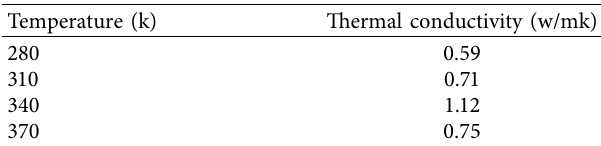
Figure 6: Heat flow correlation function (a) and thermal conductivity (b) of composites at 320K. Table 3: Thermal conductivity of carbon nanotubes at different